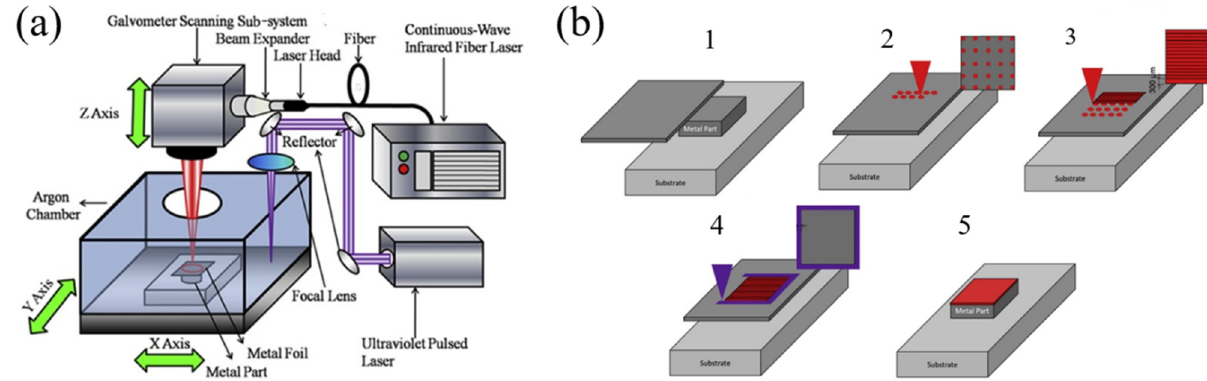
Figure 9. Schematic illustration of ( a ) the LFP system, ( b ) LFP steps. Reproduced from [106], with permission from Elsevier, 2021.